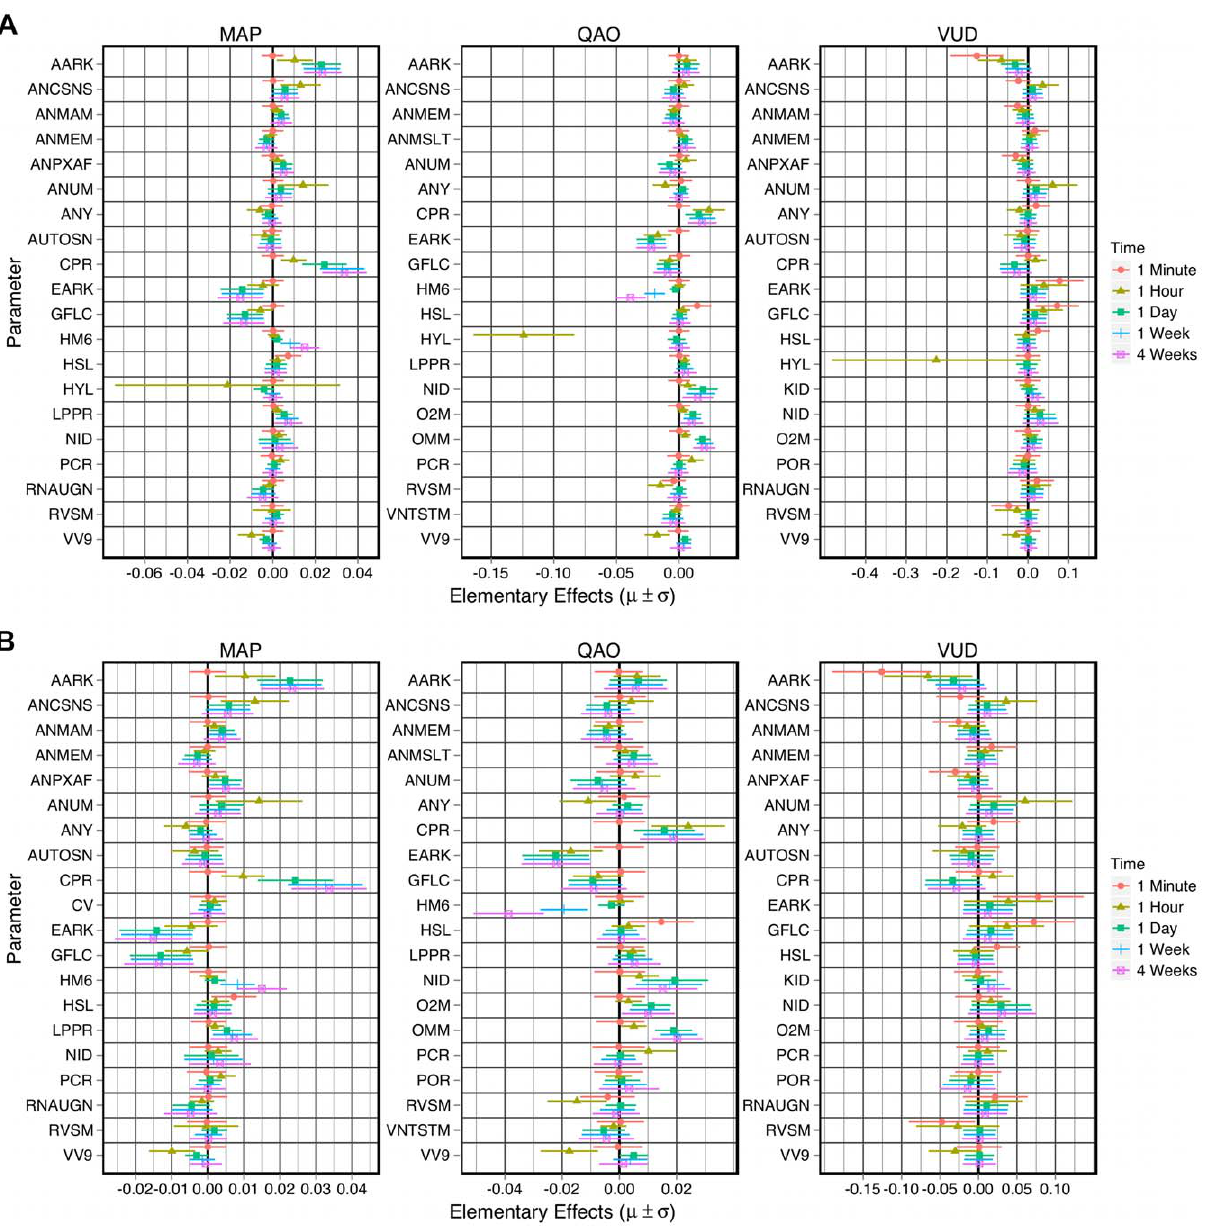
Figure 2. The most significant elementary effects on three key output variables at each time t [ T EE . A: The effects on mean arterial pressure (MAP), cardiac output (QAO) and rate of urine production (VUD) are plotted (at t ~ 1 minute,1 hour,1 day,1 weekand 4 weeks after the perturbations) as m + s . B: The most significant elementary effects when HYL is ignored. The complete tables of elementary effects are included in the supplementary